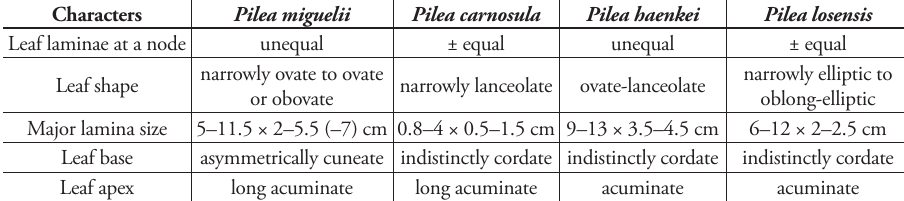
Table 2. Diagnostic characters that distinguish Pilea miguelii and several similar